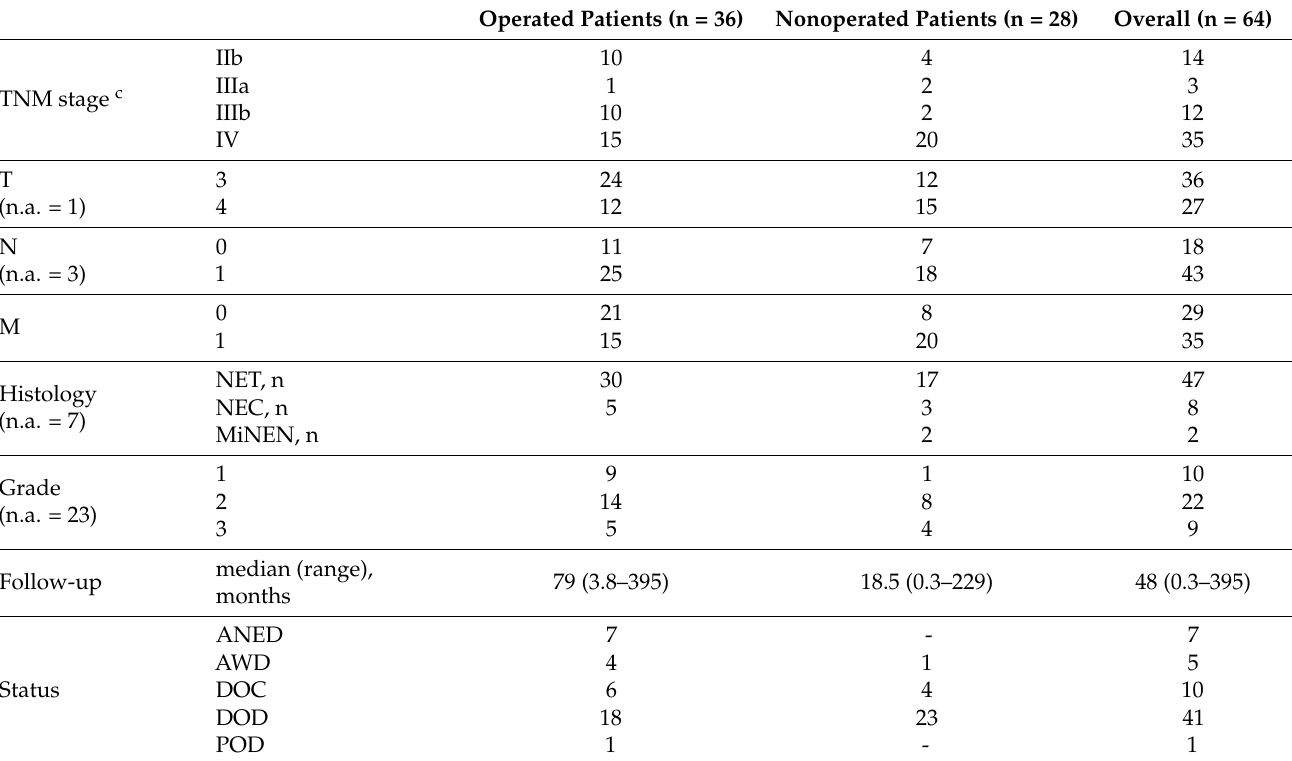
Table 1. Cont. Operated Patients (n = 36) Nonoperated Patients (n =